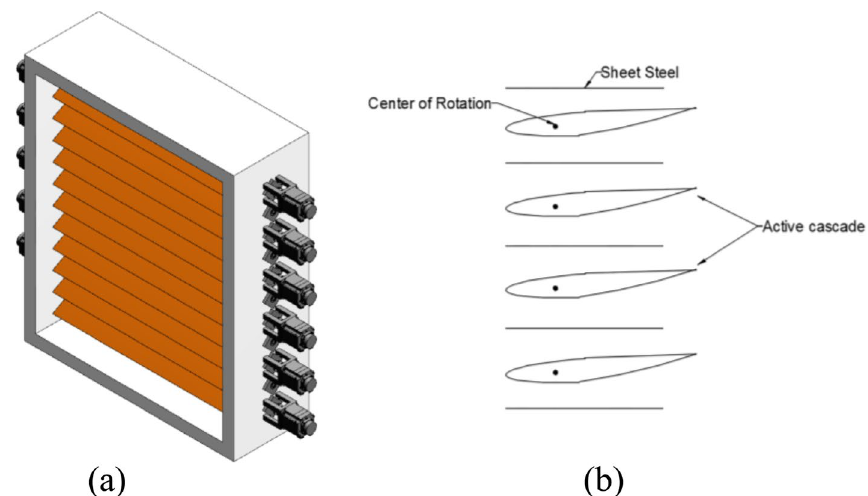
Fig. 7 Hunan University’s Open/close grid device of the atmospheric boundary layer (ABL) a Layout sketch of the horizontal wings at the entrance of the wind tunnel. b Horizontal wings and horizontal demarcation strip (Han, 2007)